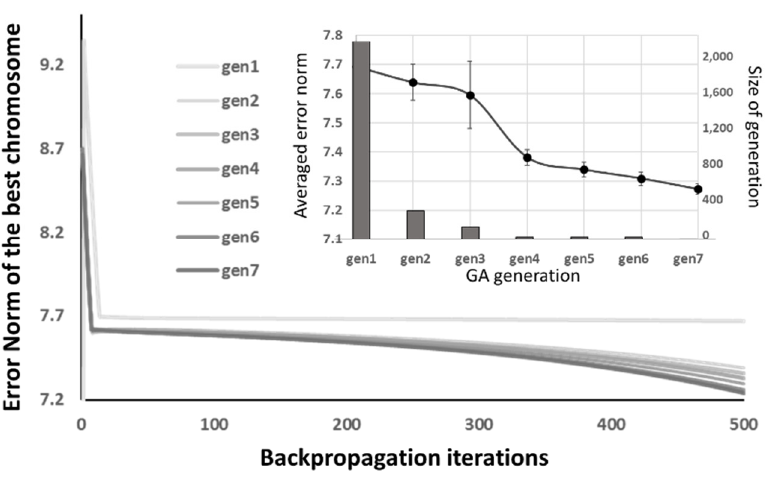
Figure 14. The performance of the GA generations under the “back-to-original” optimizer.